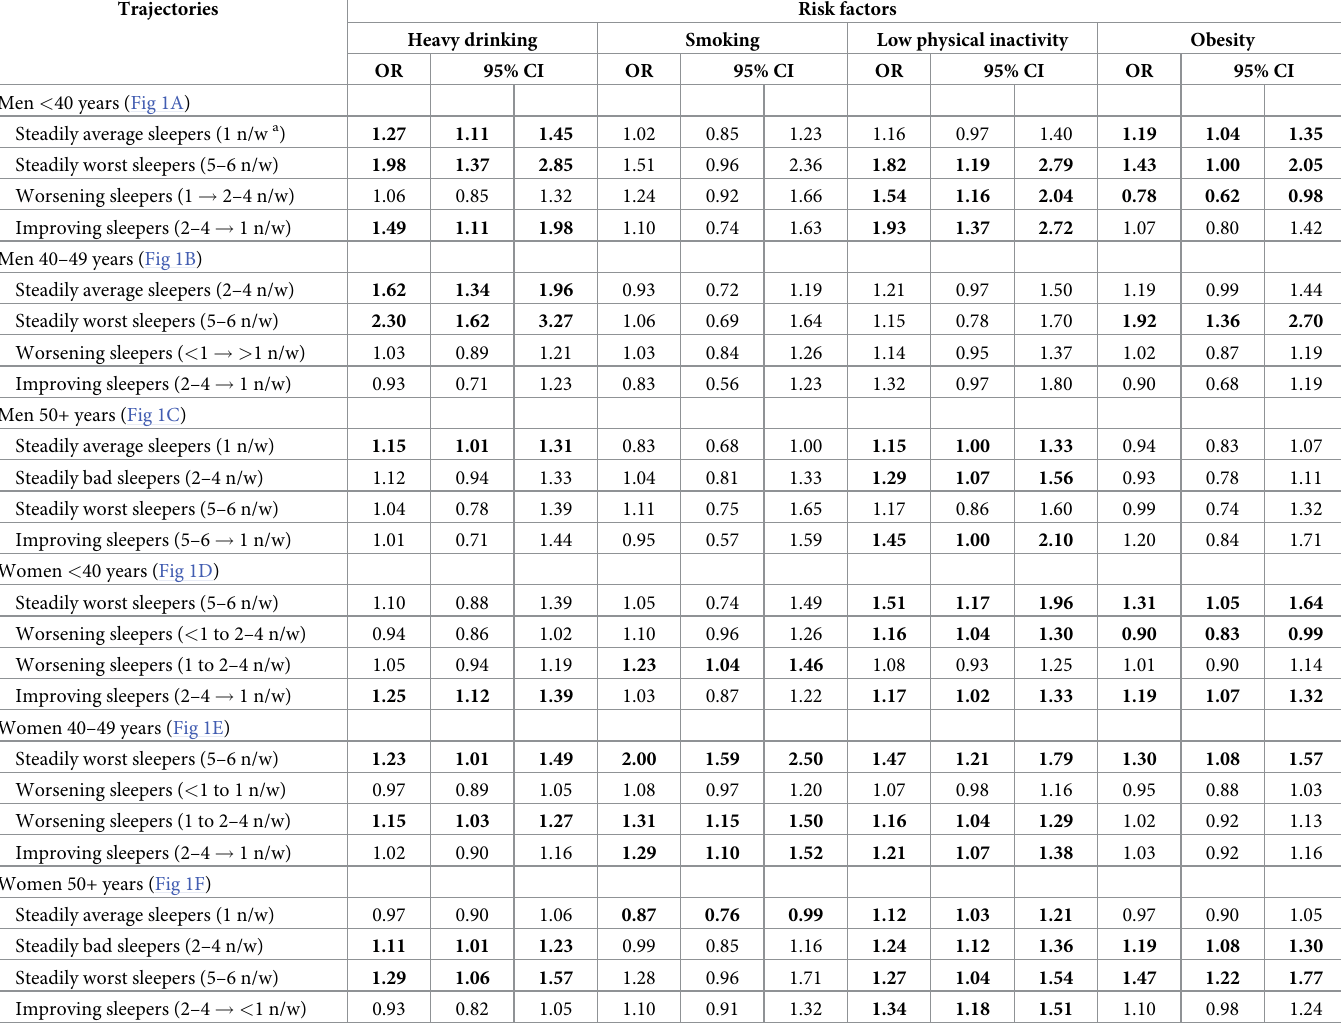
Table 2. The strength of prediction amongst modifiable risks and probability of being placed into a particular